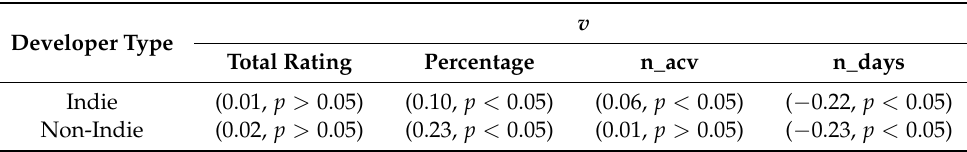
Table 8. v correlation to total rating, achievement percentage, number of achievements, and number of days since the game is